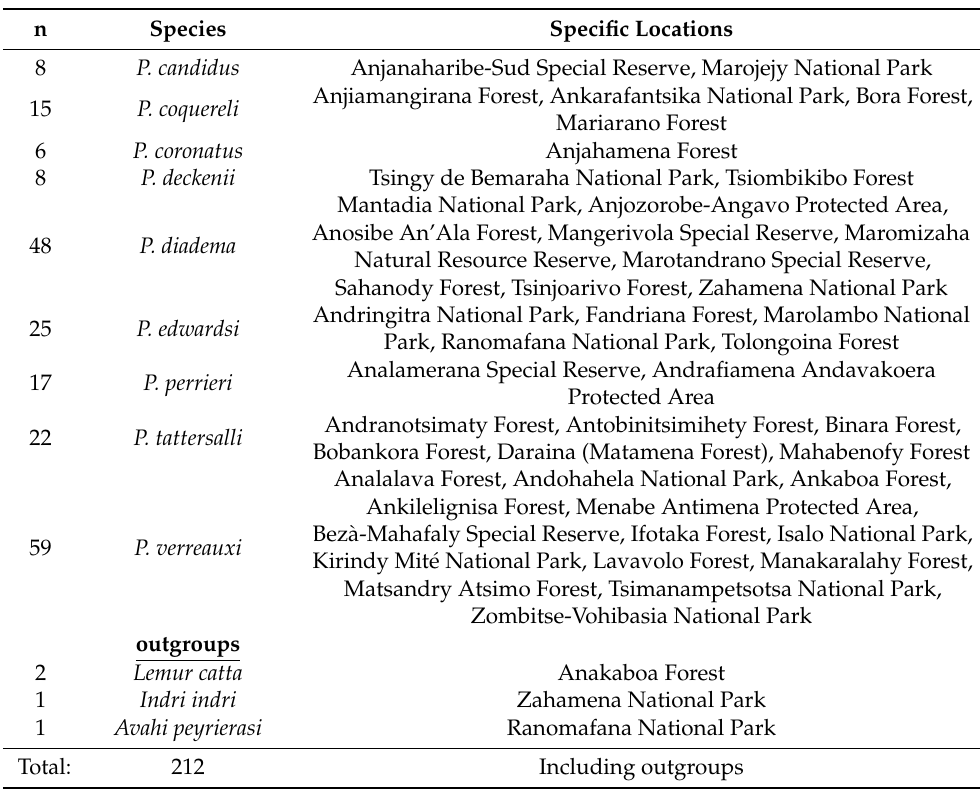
Table 1. Summary of the number of individuals across each species and locations included in this study. Additional details can be found in Supplementary Table